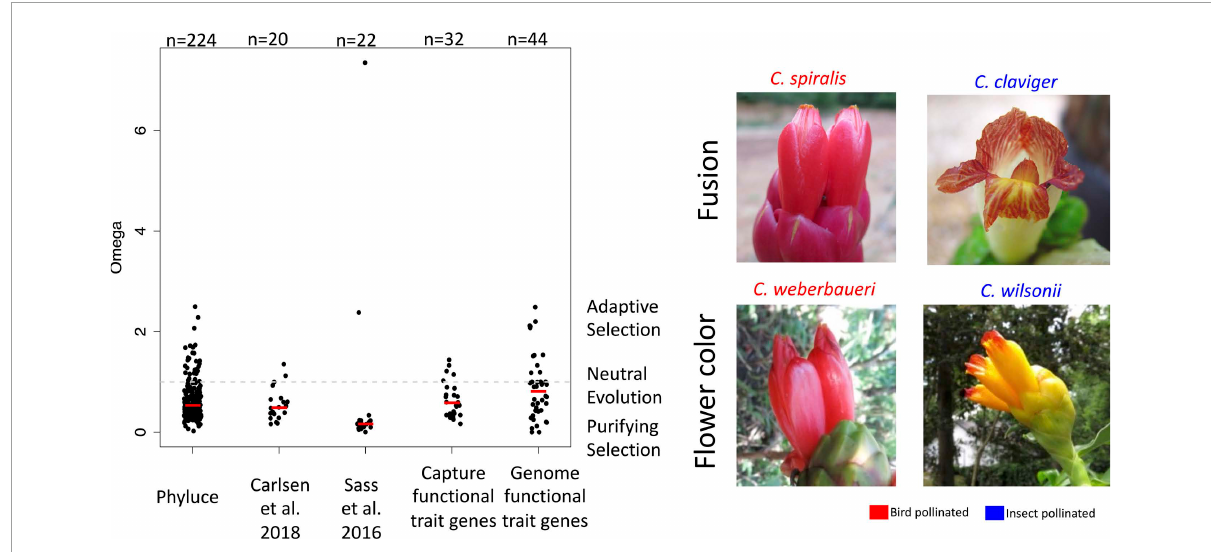
FIGURE6 Strip plots showing the omega value for 342 loci investigated for signatures of selection in PAML, with the median value of each group of loci represented with the red line. The different columns represent different approaches of how the loci were generated, such as from Phyluce, Carlsen et al. (2018), Sass et al. (2016), and genes representing functional traits. The fifth column represents genes of functional traits isolated with consensus calling of the genomic Illumina DNA. The gray dotted line represents omega values of neutral evolution; omega values above one signifies positive selection and omega values less than one represent purifying selection. Examples of how fusion and flower color change across different pollination types are also highlighted, with genes of these function traits included in the last two columns of the strip plot.